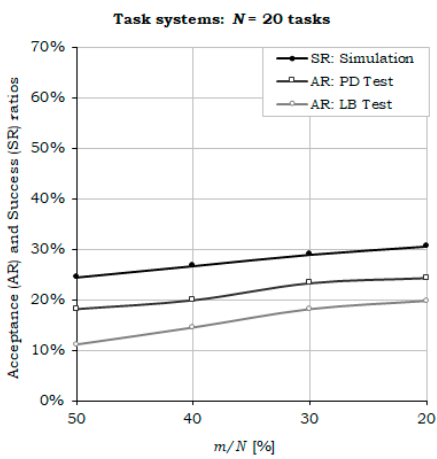
Figure 7. Acceptance and success ratios, while decreasing the proportion of FENP tasks ( m / N ratio).